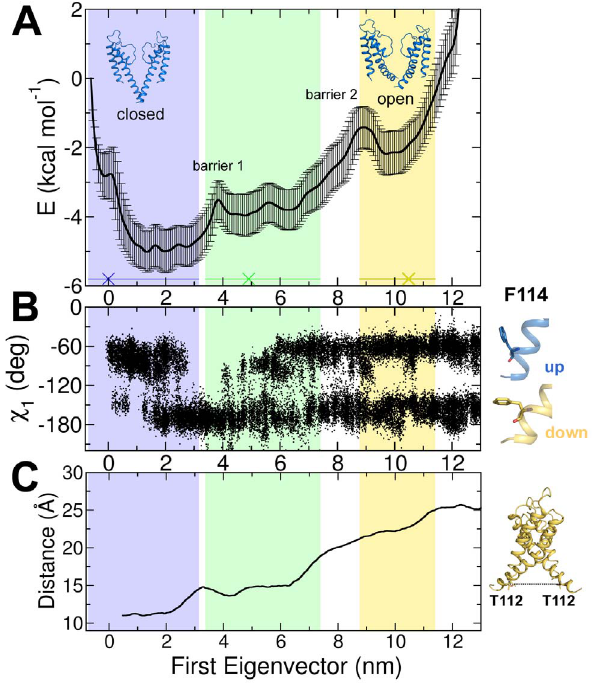
Figure 4. Free energy profile of gate opening. The blue, green, and yellow shades depict the sampling of the closed, intermediate, and open structures along the first EV. A) Free energy profile of the activation gate opening derived from 3.9 m s umbrella sampling simulations. The X marks indicate the positions of the crystal structures. B) x 1 angle dynamics of all four F114 during activation gating. C) Distance between opposite T112 as a measure of pore opening.